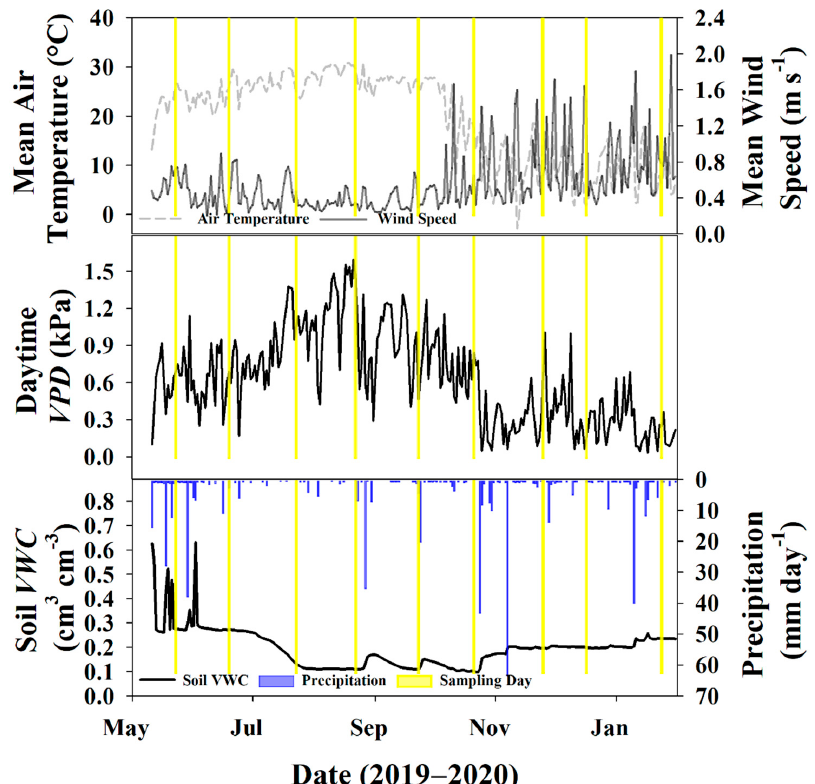
Figure 3. ( A ) Thirty-minute average air temperature and wind speed recorded from the eddy covariance (EC) tower during the study period; ( B ) average daytime (6:00–18:00 h) vapor pressure deficit ( VPD ); ( C ) and soil volumetric water content ( VWC ) at 0.16 m depth at soil plot 1 along with daily precipitation totals. Days where there was an isotope sampling event (soil and twigs) are highlighted in